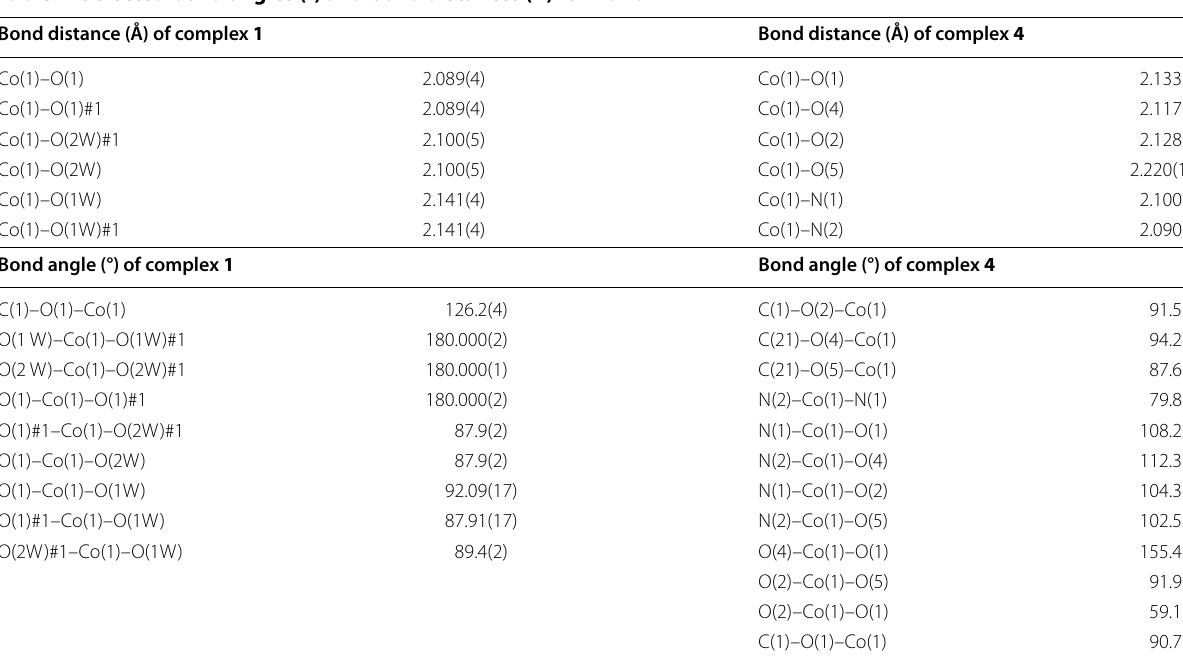
Table 1 Selected bond angles (°) and bond distances (Å) for 1 and